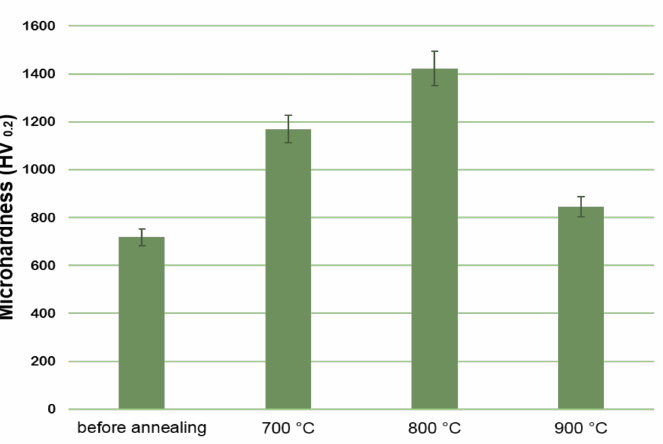
Figure 8. Effect of annealing temperature on the microhardness of coatings based on Ti–Si–C.